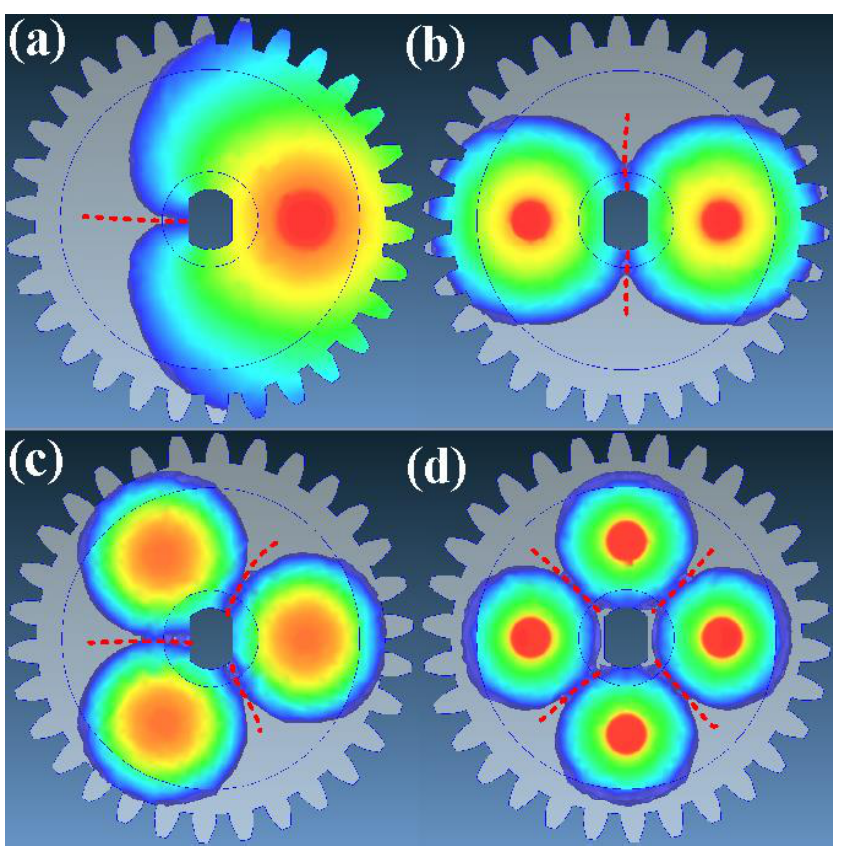
Figure 10. Weld line results for different gate numbers of ( a ) single point, ( b ) two points, ( c ) three points, and ( d ) four points.